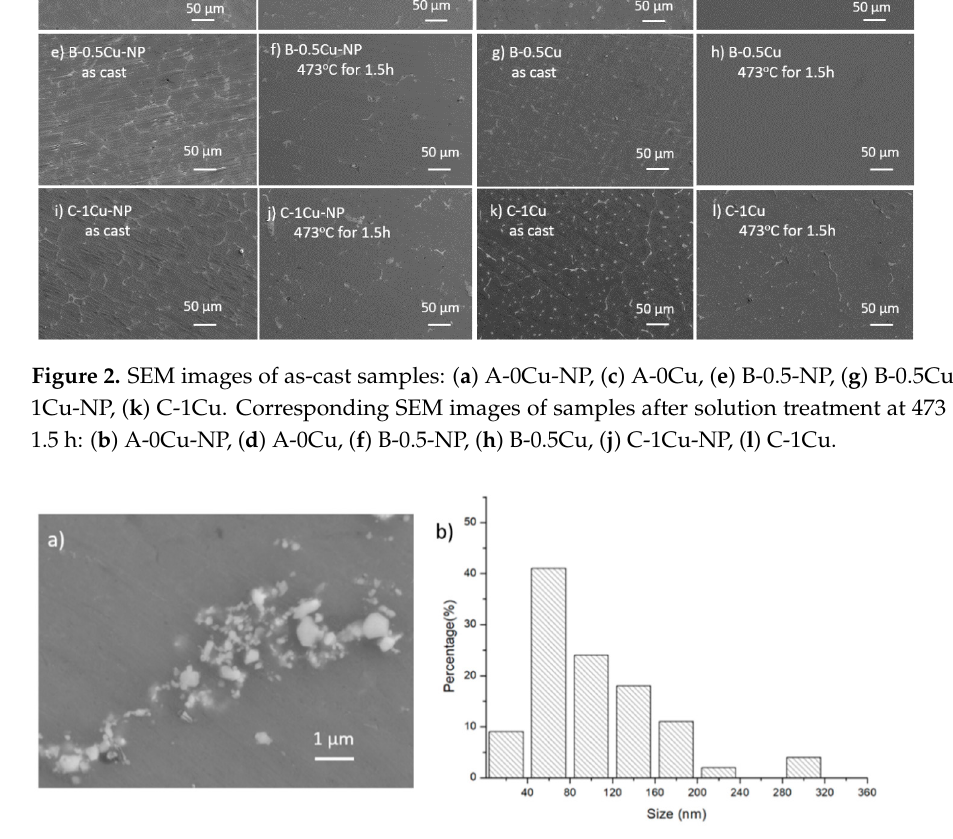
Figure 3. ( a ) SEM images of remaining TiC nanoparticles after solution treatment from sample A- 0Cu-NP; ( b ) nanoparticle size distribution